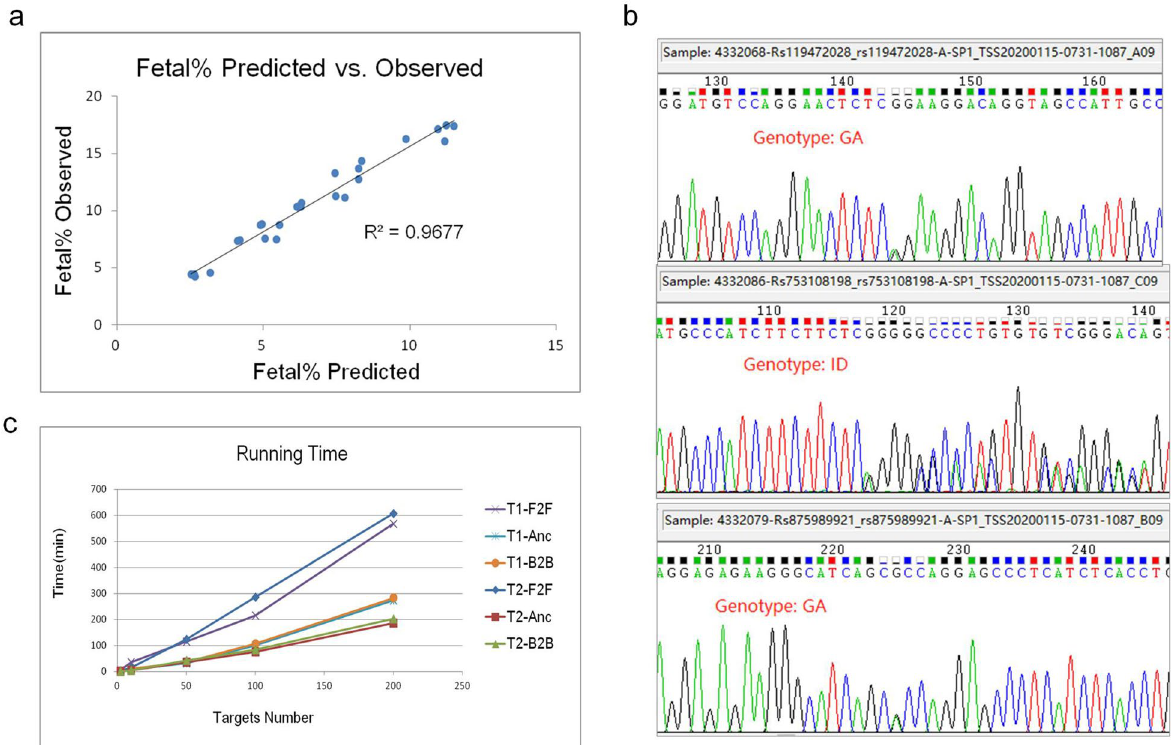
Figure 8. Evaluation of accuracy of the predicted fetal DNA fraction, Sanger sequencing results, and evaluation of running time of PrimerScore2. ( a ) Comparison of predicted fetal DNA fraction in cfBEST and observed by the gold standard method (Y-assay). ( b ) Sanger sequencing results of the three examples in Sanger sequencing genotyping project. The genotypes were GA, ID (‘I’ is insertion; ‘D’ is deletion) and GA, respectively. ( c ) Running time of three primer orientations ( F2F Face-to-Face, generic primers, Anc Anchored primers, B2B Back-to-Back, inverse primers) in five ranks of target numbers: 2, 10, 50, 100, and 200. Two target sets (T1 and T2) were